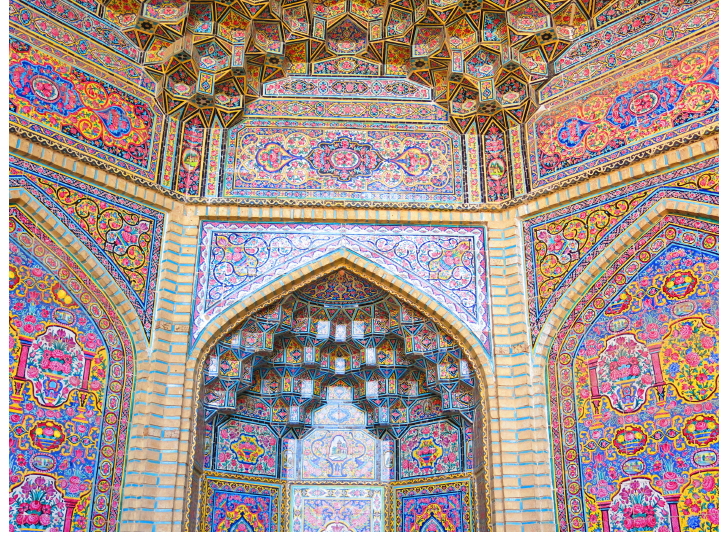
Figure 3. Nas¯ır al-Mulk Mosque of Shiraz, Iran (Photo by Zhou Chuanbin, 2017). The Mosque was built in the 19th century under the rule of the Qajar dynasty (1789–1925), which is famous for its rose ceramic tiles and colored glass, which makes people feel like they are in a colorful